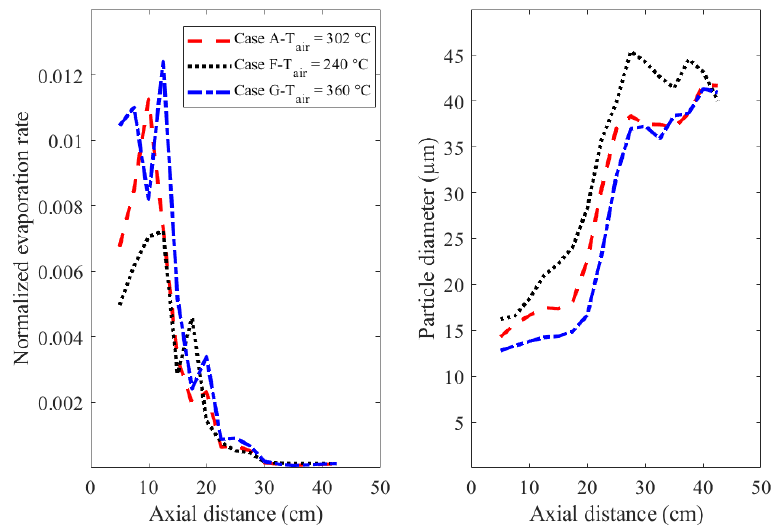
Figure 14. Normalized evaporation rates ( left ), and average particle diameters ( right ) along the axial height of the dryer for cases A, F and G (location of atomizer = 0). Table 6. Particle mean diameter and mean residence time at outlet.